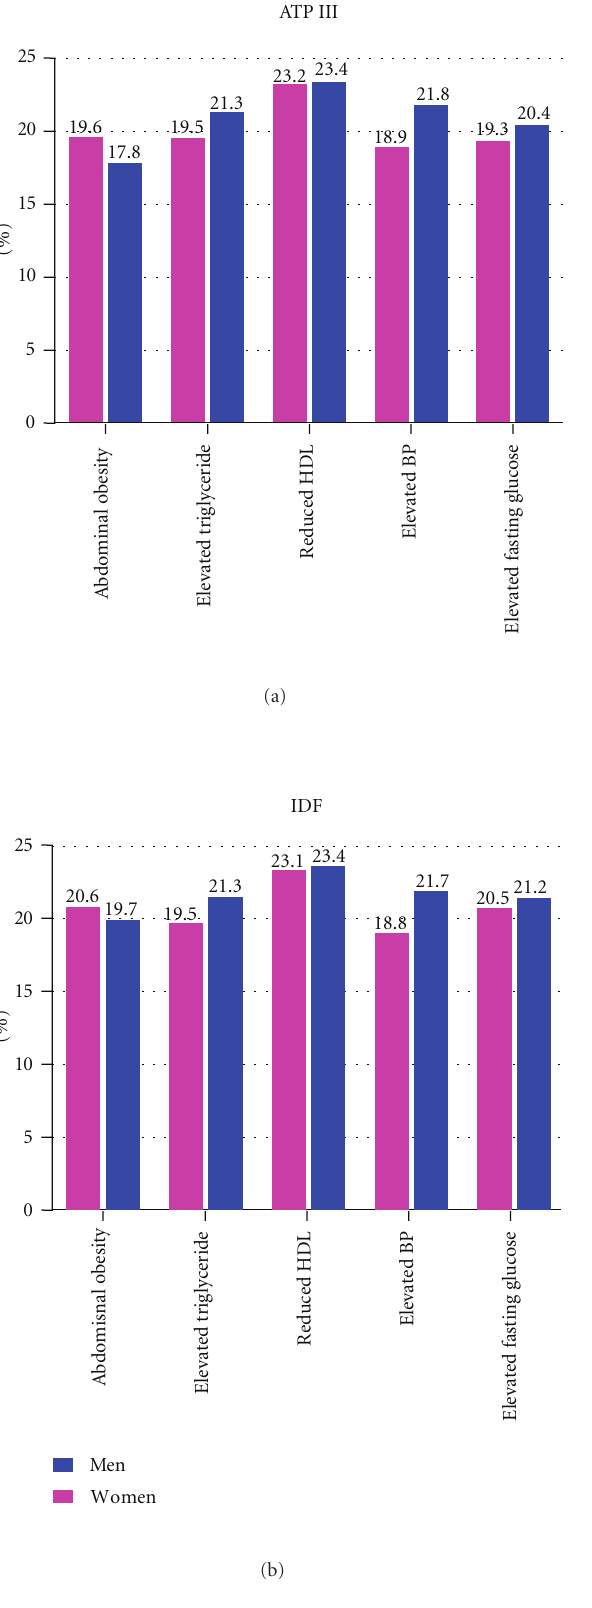
Figure 1: Age-adjusted prevalence of metabolic syndrome compo- nents by gender according to ATP III and IDF criteria.